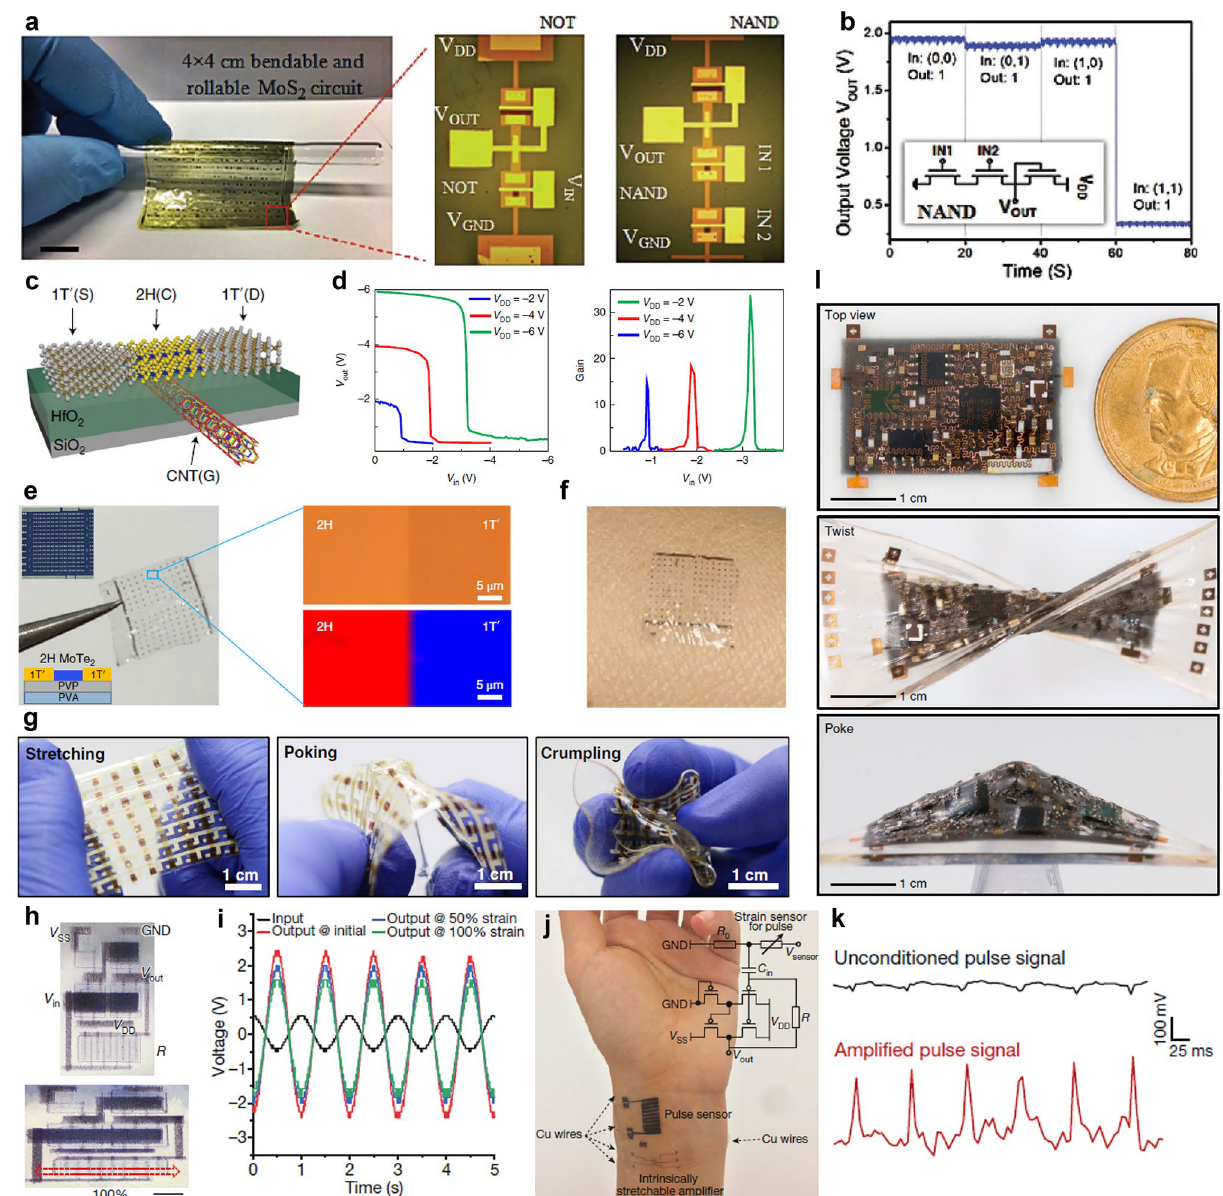
Fig. 34 Soft ICs. a Photograph of the rollable logic circuits wrapped around glass pipette together with magnified NAND and NOT structure. Scale bar represents 1 cm. b Schematic and measurement results of the NAND gates on the PI substrate. Reproduced with permission [394]. Copyright (2018), Wiley–VCH. c Schematic of a 1T/2H MoTe 2 FET with a CNT gate. d Transfer characteristics of the inverter operating at V DD = − 2, − 4, and − 6 V. Gains of the inverter for the same vales of V DD . e Self-supporting substrate with an array of 144 stretchable transis- tors. Insets: photograph of the device array on SiO 2 /Si substrate before peeling-off (top) and cross-sectional schematics of the devices (bottom). Optical and Raman mapping image of a 1T/2H MoTe 2 junction on PVP/PVA film, respectively. f MoTe 2 devices with PVP/PVA substrate on skin. Reproduced with permission [395]. Copyright (2019), Springer Nature. g Transistor arrays under different mechanical deformation such as stretching, poking, and crumpling. Reproduced with permission [396]. Copyright (2019), American Association for the Advancement of Sci- ence. h Optical microscope images of a stretchable amplifier in initial state (top) and stretched to 100% strain (bottom). i Input and output signals after amplification at 0%, 50%, and 100% strain. j Stretchable amplifier applied to amplify arterial pulse signals measured by a stretchable strain sensor. The devices are attached on skin side-by-side. k Pulse signals before and after amplification. Reproduced with permission [398]. Copy- right (2018), Springer Nature. l Optical micrographs of the system when freestanding (top), twisted (middle) and poked (bottom). Reproduced with permission [399]. Copyright (2018), Springer